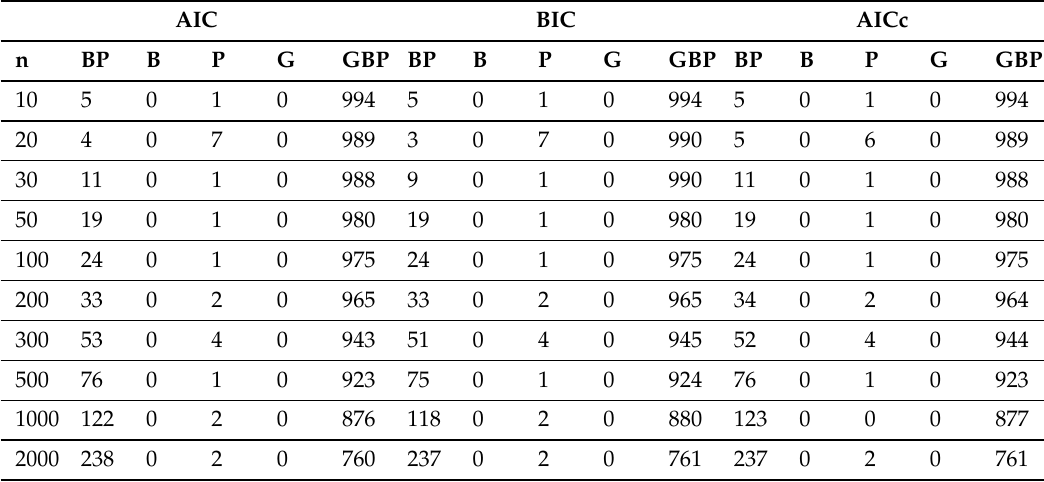
Table 18. Smaller AIC/BIC/AICc scores in 1000 simulations from a censored GBP